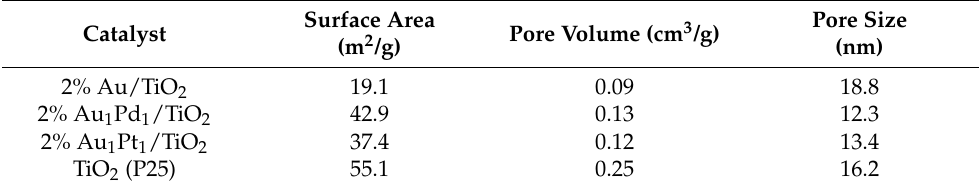
Table 4. Textural properties of the catalysts.